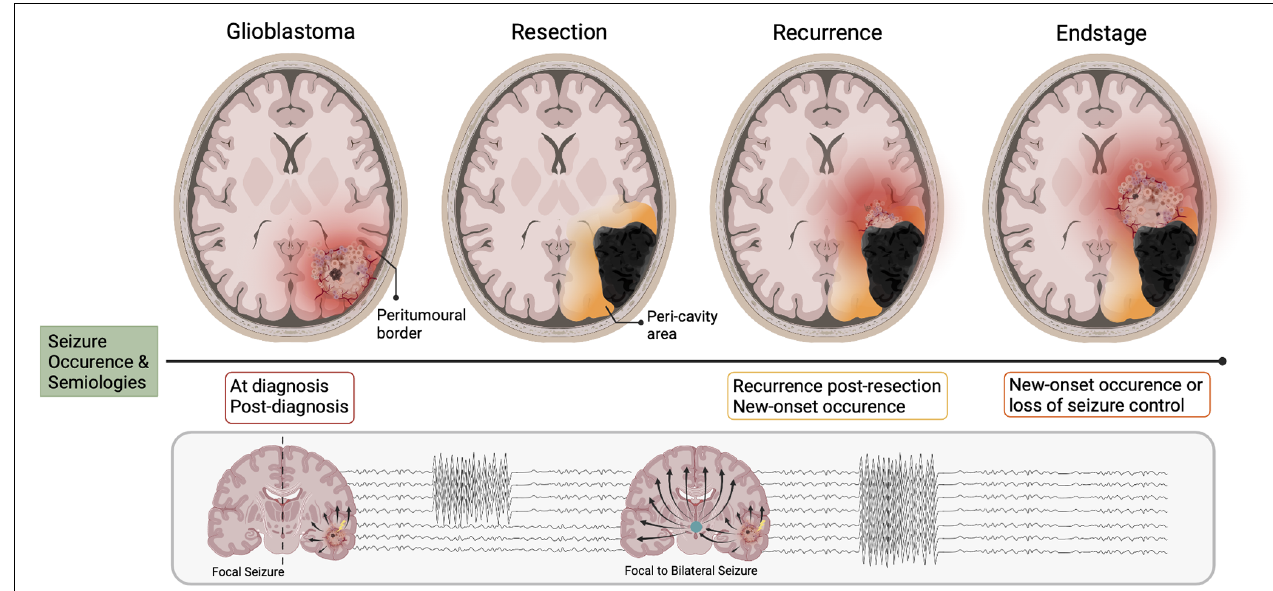
FIGURE 1 | Seizure occurrence and pathoanatomical changes relative to disease stages in glioblastoma. The different stages of glioblastoma progression are associated with their own relationship to seizure occurrence, of which focal and focal-to-bilateral are the most common semiology. When the bulk tumor is present (glioblastoma), the area where tumor meets “normal brain” is known as the peri-tumoral border (in red). The network organization of this area changes progressively with disease evolution. Upon resection, the peri-tumoral border is now termed the peri-cavity area. Now independent of the glioblastoma, this area may become intrinsically epileptic. When the tumor recurs, areas of the peri-cavity area now merge with the new peri-tumoral border (orange/red). At the endstage of the disease, the peri-cavity area and peri-tumoral border are simultaneously present (orange/red). Therefore, there are a multitude of mechanisms generating seizure activity both in the new peri-tumoral border and the epileptic peri-cavity